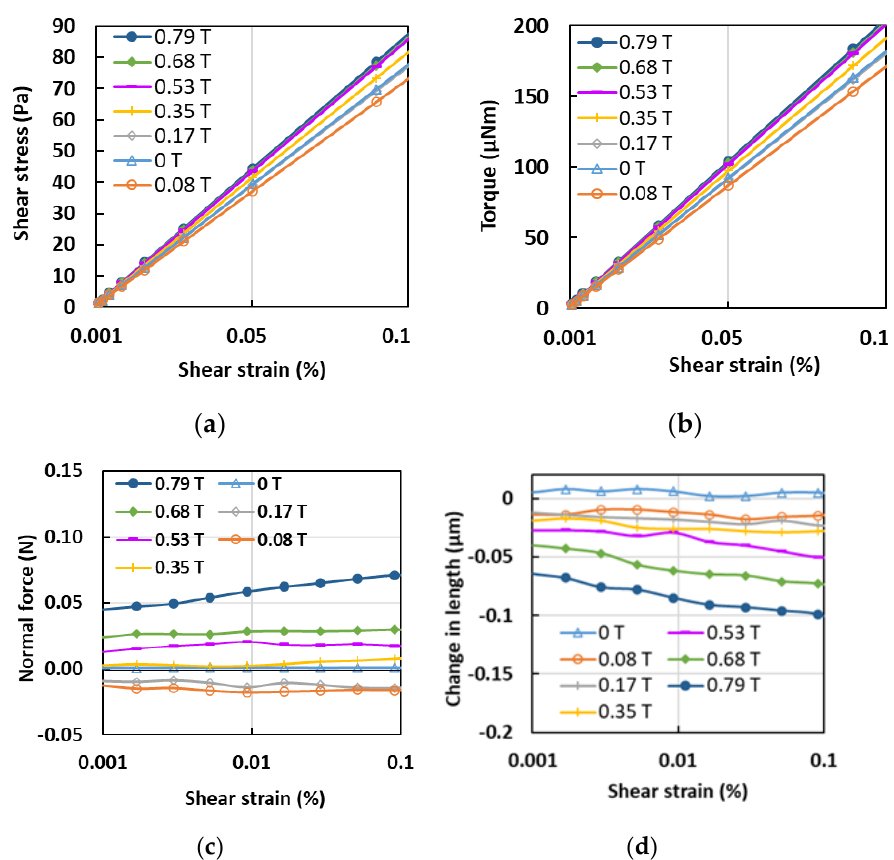
Figure 6. Relationship of ( a ) shear stress, ( b ) torque, ( c ) normal force and ( d ) change in length with shear strain at different magnetic field strengths.